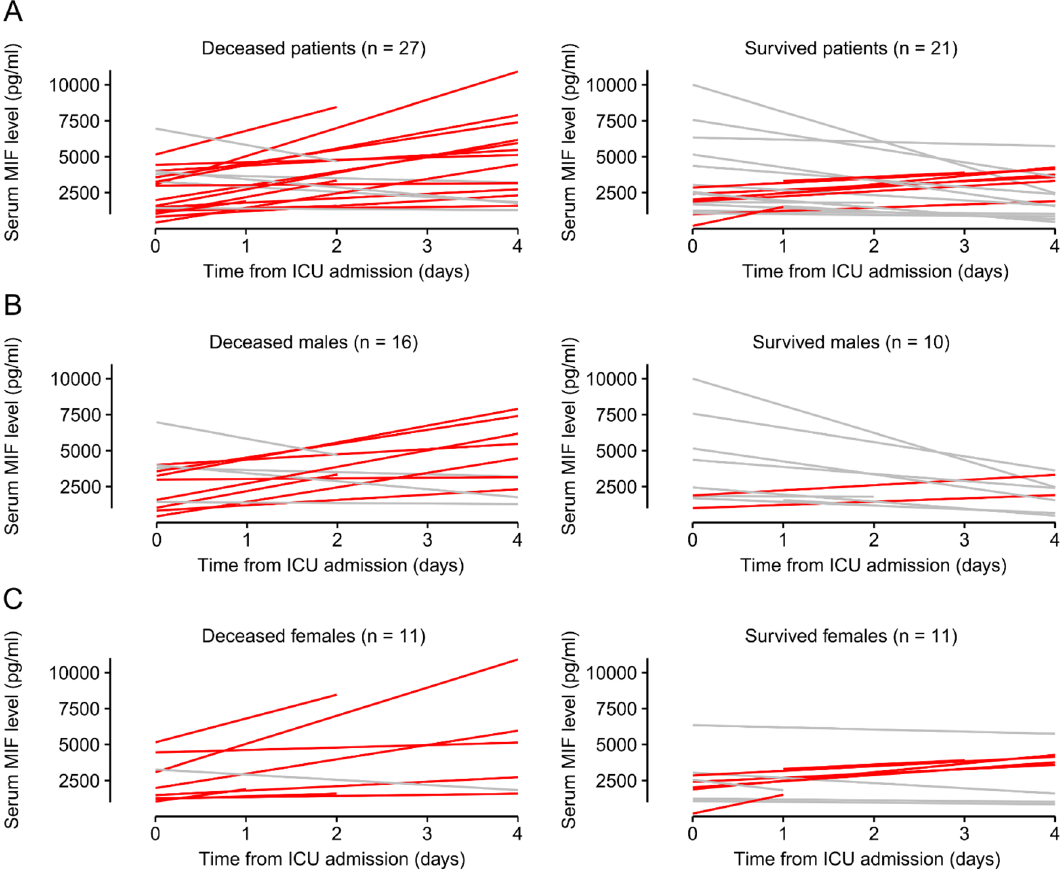
Figure 3. The individual pattern of serum macrophage migration inhibitory factor (MIF) kinetics in each patient who had at least 2 measurements between day 0 and 4 at the intensive care unit (ICU). Red line indicates an increase, while gray line shows no increase in serum MIF level in deceased and survived patients based on data obtained from ( A ) both sexes, ( B ) females, and ( C ) males. The number of patients (n) is indicated in the figure in each